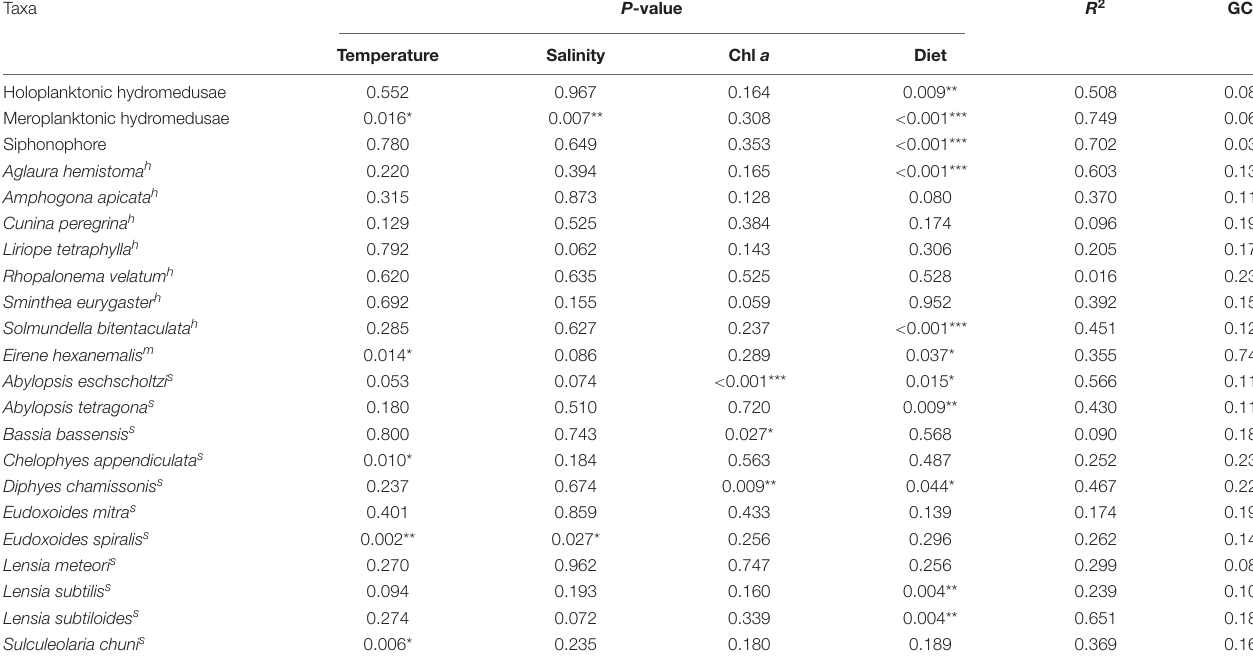
TABLE 3 | Generalized additive model results for medusae and environmental factors among three transects.